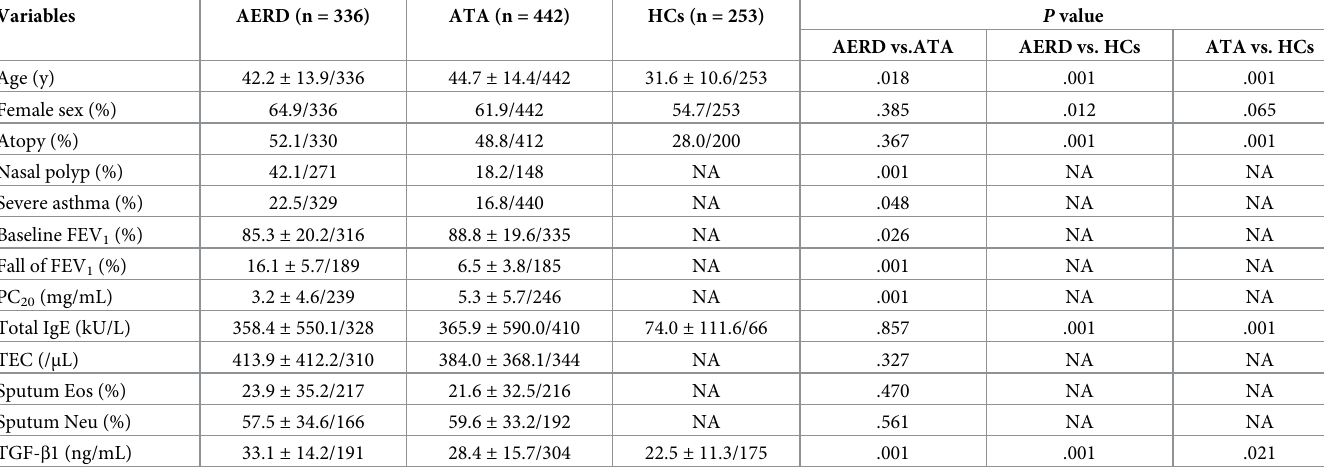
Table 1. Demographic data from the study subjects enrolled in the first cohort of adult asthmatic patients. Variables AERD (n = 336)